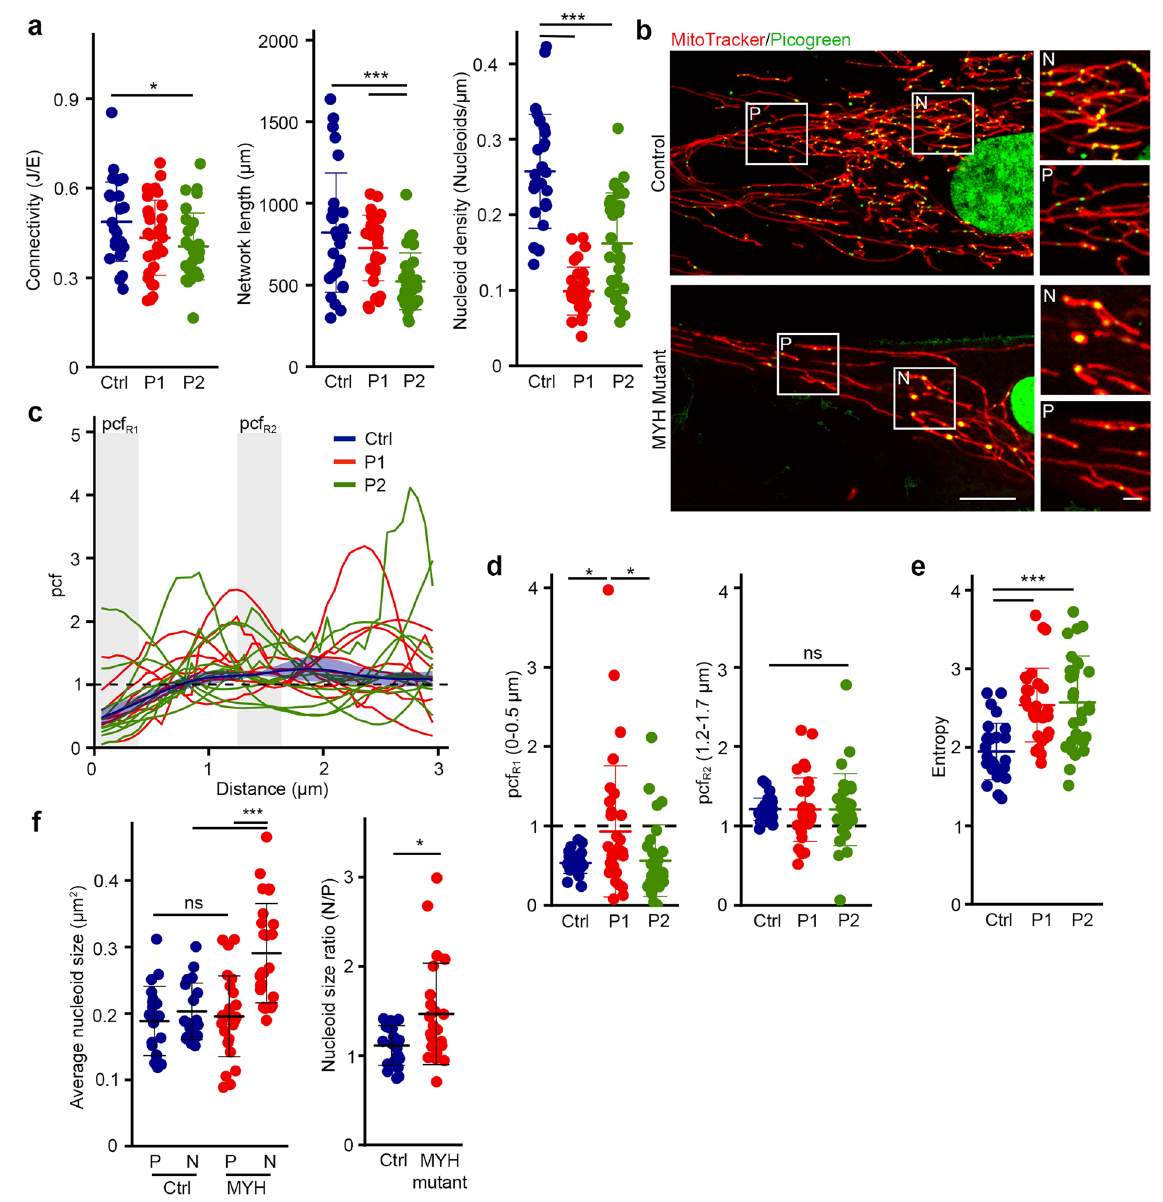
Figure 4. MYH14 is required for proper nucleoid distribution. ( a ) Mitochondrial parameters in Control and MYH14 mutant primary human fibroblasts (P1: Patient 1, P2: Patient 2). Each data point represents one cell. Bars represent the average of 30 cells ± SD. *p = 0.032 (Connectivity, Ctrl vs P2), ***p = 0.0000869 (Network length, Ctrl vs P1), p = 0.0073460 (Network length P1 vs P2), p = 1 × 10 –6 (Nucleoid density, Ctrl vs P1 / P2). One-way ANOVA. ( b ) Representative live cell confocal images of control and MYH14 mutant primary fibroblasts stained with mitotracker red (mitochondria) and picogreen (DNA) Scale bar, 10 µm; 2 µm for zoomed images. P, periphery; N, perinuclear. ( c–e ) Nucleoid distribution in control and MYH14 primary human fibroblasts. ( c ) pcf curves. The solid line for the control (Blue) represents the average distribution and the shaded area, the SD (n = 8 cells). For the MYH14 mutants, each solid line represents one individual cell (n = 9 cells per patient line), highlighting the variability of the pcf. The dashed line represents the expected random distribution and the grey areas, the distances for which the average pcf was quantified in (d; pcf R1: 0–0.5 µm, pcf R2: 1.2–1.7 µm). ( d ) Average pcf values at short and longer distances. Each data point represents one cell. Bars represent the average of 30 cells ± SD. *p = 0.0182065 (Ctrl vs P1), p = 0.0280752 (P1 vs P2), ns not significant. One-way ANOVA ( e ) Entropy values calculated from the pcf curves in ( c ). Each data point represents one cell. Bars represent the average of 30 cells ± SD. ***p = 0.0000502 (Ctrl vs P1), 0.0000891 (Ctrl vs P2). One-way ANOVA. ( f ) Average nucleoid size in peripheral (P) and perinuclear (N) regions (Left) and nucleoid size ratio (Perinuclear/periphery) of control and MYH14 mutant primary fibroblasts (right). Each data point represents one cell. Bars represent the average of 20 cells ± SD. ***p = 0.0000015 (MYH mutant P vs N), p = 0.0000287 (N Ctrl vs N Mutant), ns not significant, One-way ANOVA (Left). *p = 0.01949, Two-tailed t-test